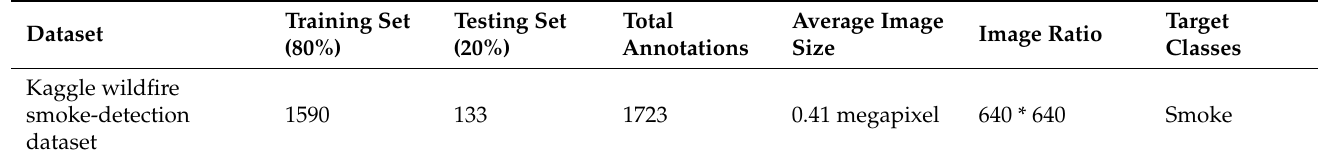
Table 2. Description of dataset following data-augmentation